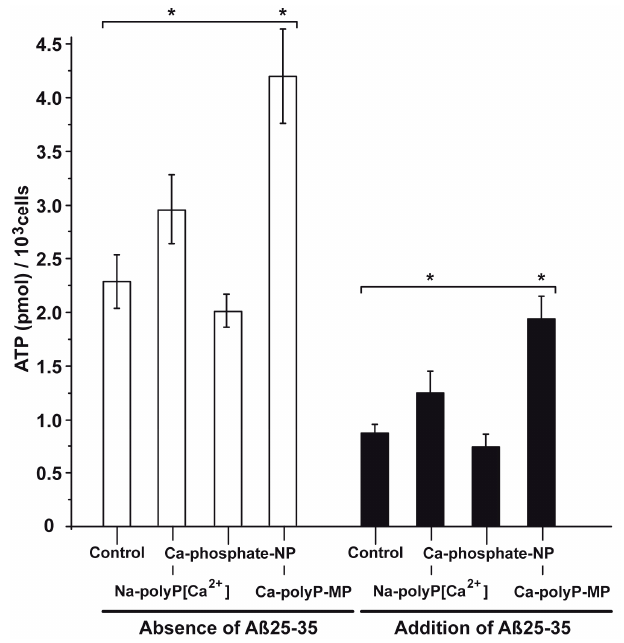
Figure 7. Change of the intracellular ATP pool in PC12 cells in dependence on the exposure to phosphate/polyP and/or A β 25-35. In the first series the cells were exposed only to phosphate/polyP and not to A β 25-35; open bar. In the A β 25-35 test series (closed bars) the cells were treated with 5 µ M of the peptide and remained either untreated (control) or were exposed to 30 µ g/mL of Na-polyP[Ca 2+ ], Ca-phosphate-NP, or Ca-polyP-MP, as indicated. The values came from five parallel assays; the means as well as the standard deviations are given. The significant differences between the values (control [minus phosphate/polyP]) and the test samples (Na-polyP[Ca 2+ ] and Ca-polyP-MP) are indicated ( * ) p < 0.01.